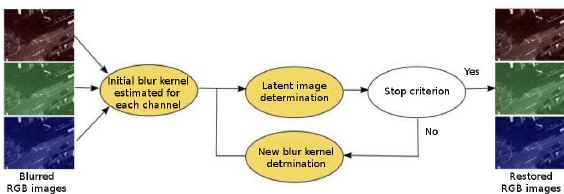
Figure 6. Description of the restoration